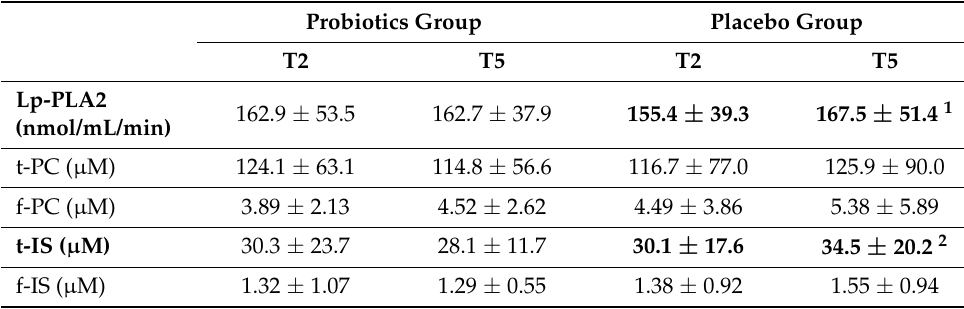
Table 3. Changes in uremic toxins. Values are presented as mean ±